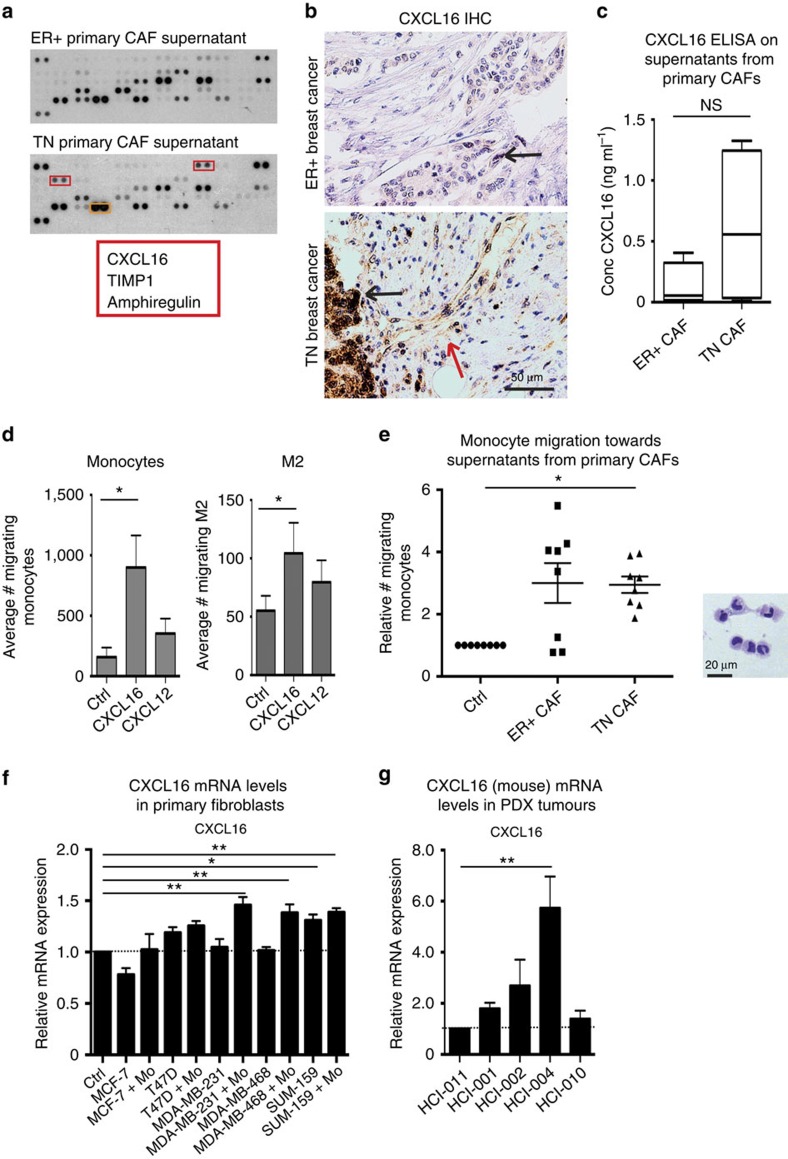
CXCL16 expression is induced in fibroblasts by myeloid cells.(a) Human angiogenesis array proteome profiler of supernatants from primary CAFs derived from ER+ or ER−PR−Her2− (triple negative; TN) tumours. (b) IHC of CXCL16 in human primary breast cancers. Upper panel shows ER+PR+ breast cancer and lower panel one TNBC. Black arrow highlights CXCL16 expressing malignant cells and red arrow, CXCL16 expressing fibroblasts. (c) The levels of secreted CXCL16 were measured using a human CXCL16 ELISA performed on supernatants prepared from primary human CAFs isolated from TN or ER+ primary breast tumours. N=4 TN and N=8 ER+. Mann–Whitney U-test. (d) Migration of primary human monocytes (left) or M2 macrophages (right) was measured using Boyden migration chambers with 8 μm pore size towards control medium (Ctrl), recombinant CXCL16 or CXCL12 as a control. *=P<0.05. ANOVA Dunn's multiple comparisons test. N=5 and N=14. (e) Migration of primary human monocytes (left) or M2 macrophages (right) was measured using Boyden migration chambers with 8 μm pore size towards control medium (Ctrl), or towards conditioned medium from primary human CAFs derived from either ER+ or TN tumours. *=P<0.05 **=P<0.01. ANOVA Dunn's multiple comparisons test. N=8. The HE image (right) shows that the migrated cells are indeed monocytes and the scale bar represents 20 μm. (f) RT-QPCR analysis of CXCL16 levels in primary mouse fibroblasts cultured in either control medium (Ctrl) or supernatants derived from luminal A (MCF-7 and T47D) or TN (MDA-MB-231, MDA-MB-468 and SUM-159) breast cancer cells with or without co-culture with primary human monocytes (Mo). *=P<0.05 **=P<0.01. ANOVA Dunn's multiple comparisons test. N=4–8. Error bars indicate s.e.m. (g) RT-QPCR analysis of infiltrating mouse cell CXCL16 levels in human PDX tumours derived from one luminal (HCI-011; set to 1) and four TN (HCI-001, 002, 004, 010) breast tumours. **=P<0.01. ANOVA Dunn's multiple comparisons test. N=6–7. Error bars indicate s.e.m.